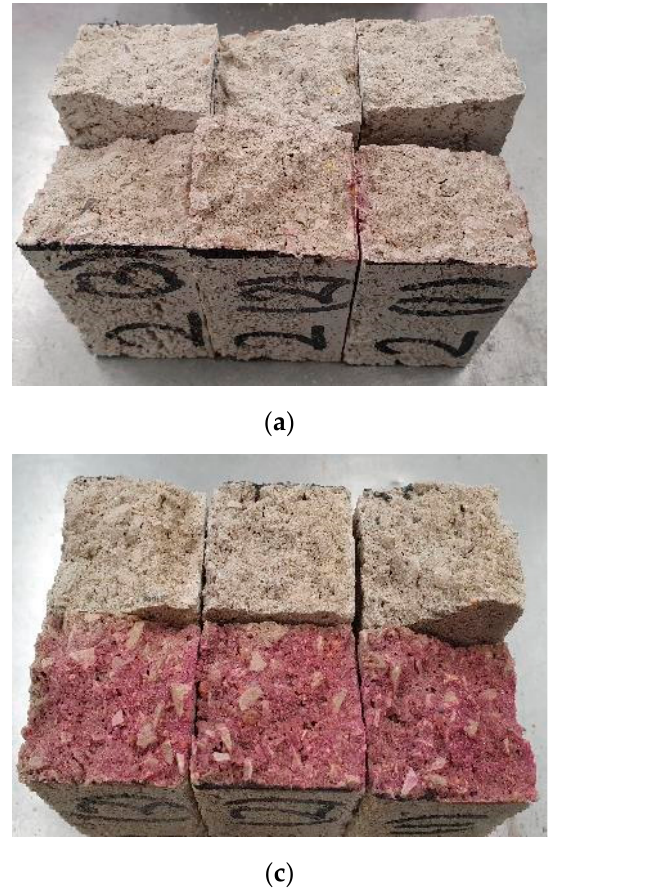
Figure 8. Efflorescence caused by sodium carbonate precipitation on the surface of N14S0 WGR specimen.